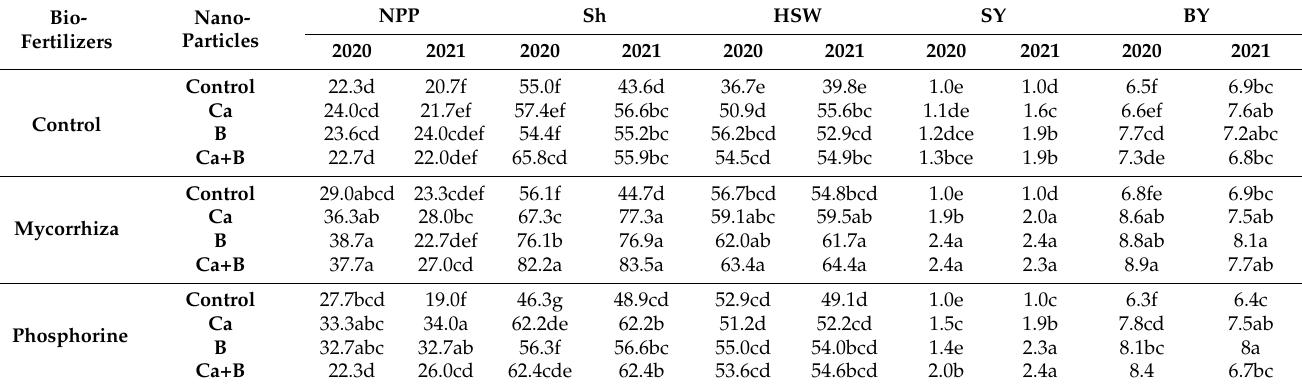
Table 2. Effects of interaction between biofertilizer and nanoparticle treatments on peanut yield and yield component traits across two successive seasons (2020 and